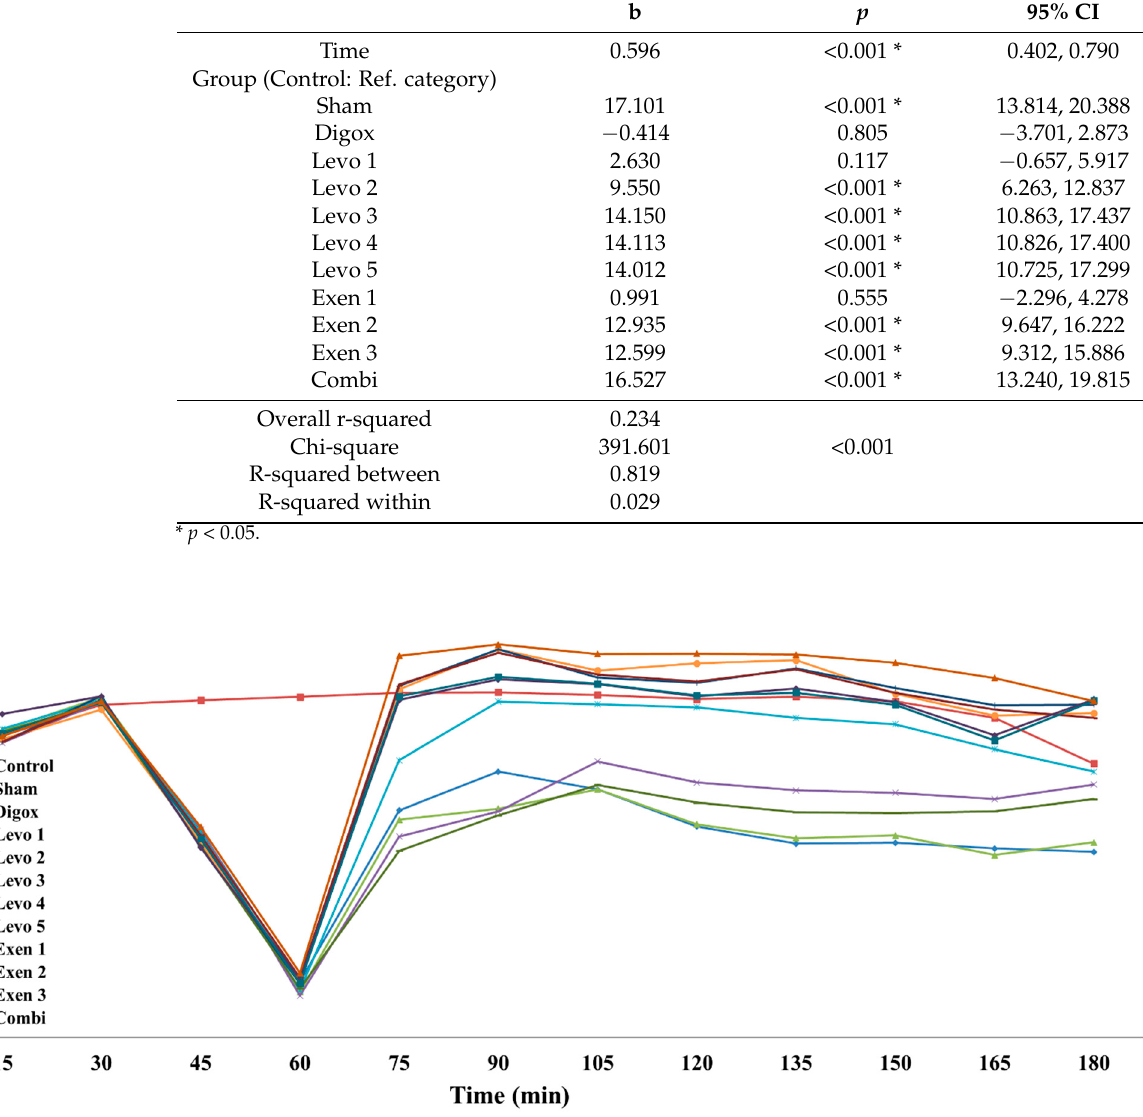
Figure 3. Changes in LVSP across groups over